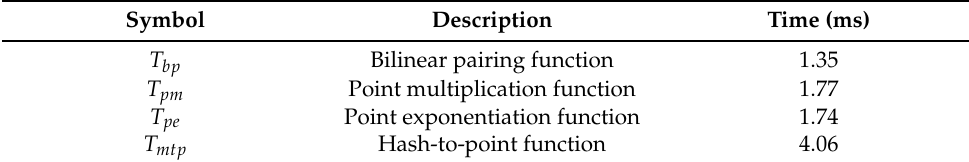
Table 2. Pairing and element functions execution